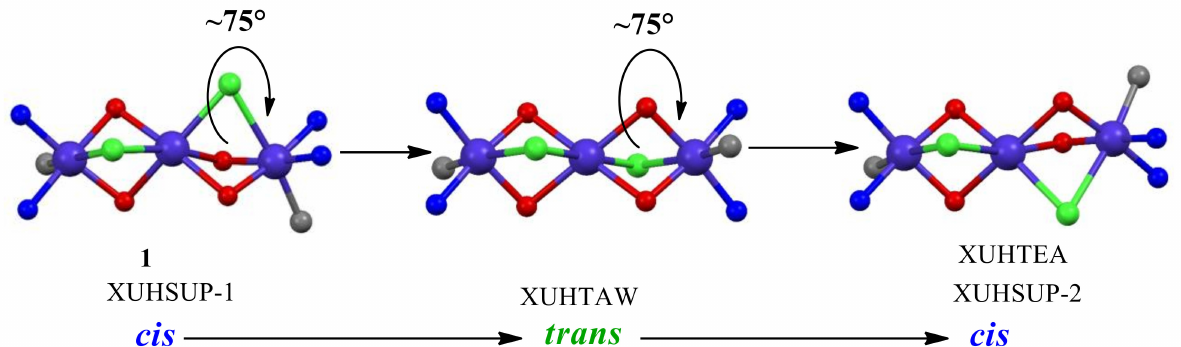
Figure 3. Rotation (by~75 ◦ ) in geometrical conversion of mixed valence Co II Co III 2 systems. Crystal structure of XUHSUP has two isomeric units, presented as XUHSUP-1 and XUHSUP-2